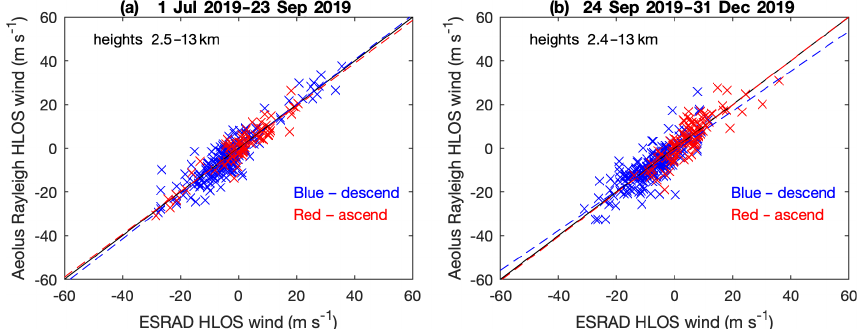
Figure 10. Scatter plots of Aeolus Rayleigh HLOS winds against HLOS winds according to ESRAD radar data. Red crosses indicate measurements made on ascending tracks and blue crosses are for descending tracks. Dashed red and blue lines show fitted regression lines. Black dashed line indicates equality. Heights indicated are the lowest and highest where valid winds are available for comparison. (a) The Arctic summer period 1 July–23 September 2019; (b) winter 24 September–31 December